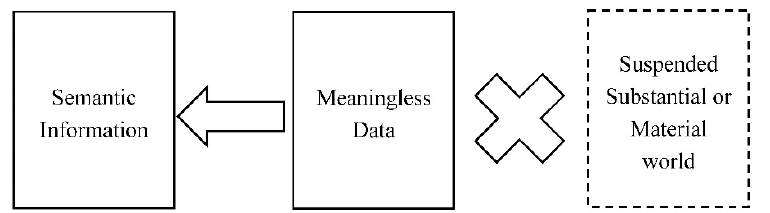
Figure 1. Floridi’s Platonic PI. The meaningless data are a platonic objective world in Floridi’s PI. When they have been captured and absorbed by a cognitive agent, they turn into semantic information. Semantic information is the precondition of knowledge. Moreover, the semantic information-based knowledge system constitutes the real structural world.